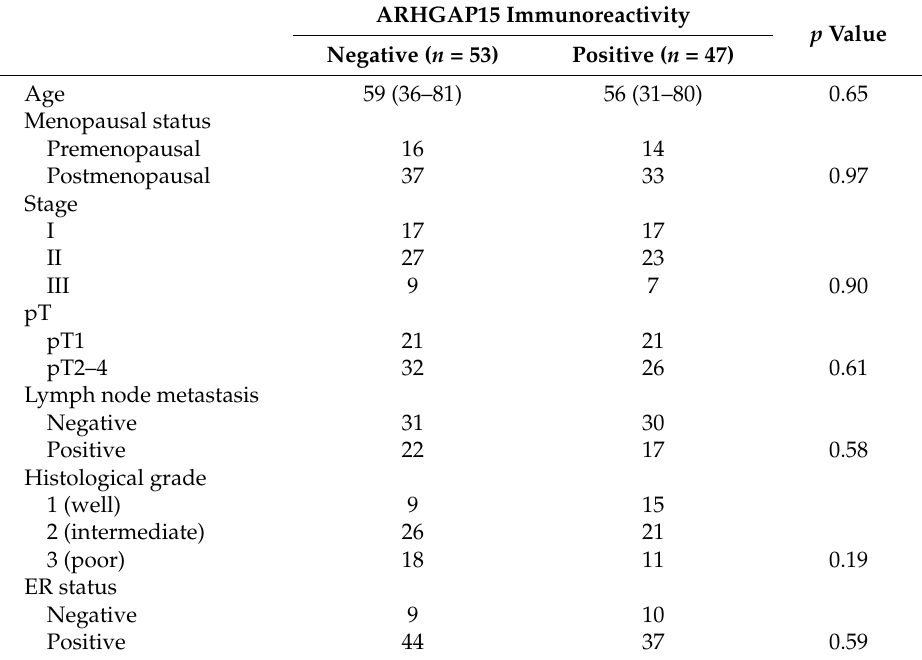
Figure 1. Immunolocalization of ARHGAP15 and Rac1 in human breast carcinoma. Immunoreactivity of ARHGAP15 and Rac1 was detected in the cytoplasm of carcinoma cells ( A , C ), while almost negligible in non-neoplastic mammary epithelium ( B , D ). Scale bar is 100 µ m for all figures. Table 1. Association between ARHGAP15 immunoreactivity and clinicopathological parameters in breast carcinoma patients ( n = 100).